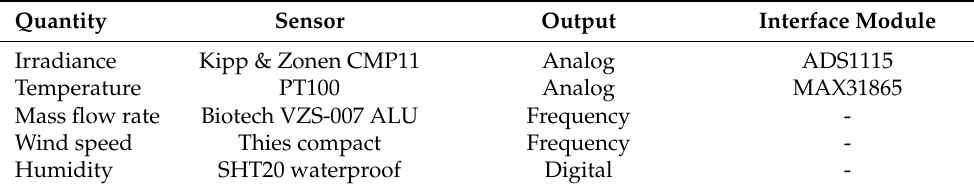
Table 2. Selected